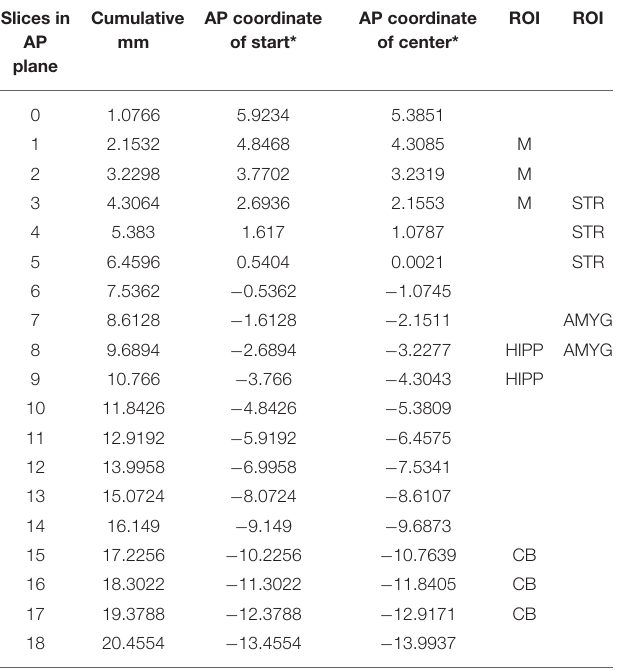
TABLE 2 | Location of ROI in coordinate space. Slices in AP